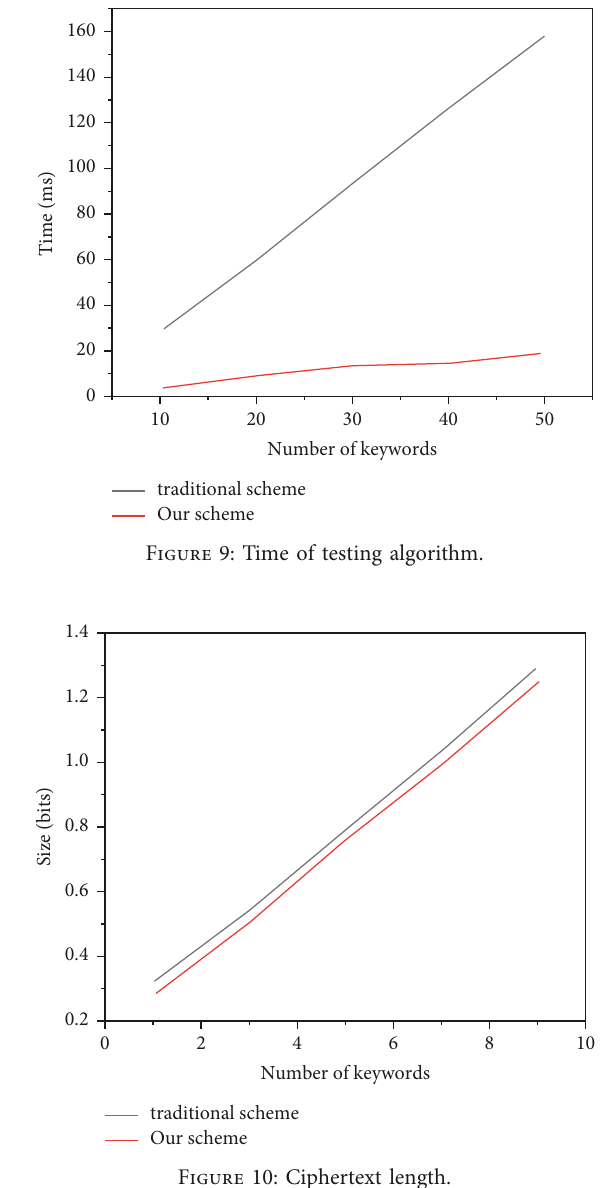
Figure 10: Ciphertext length.